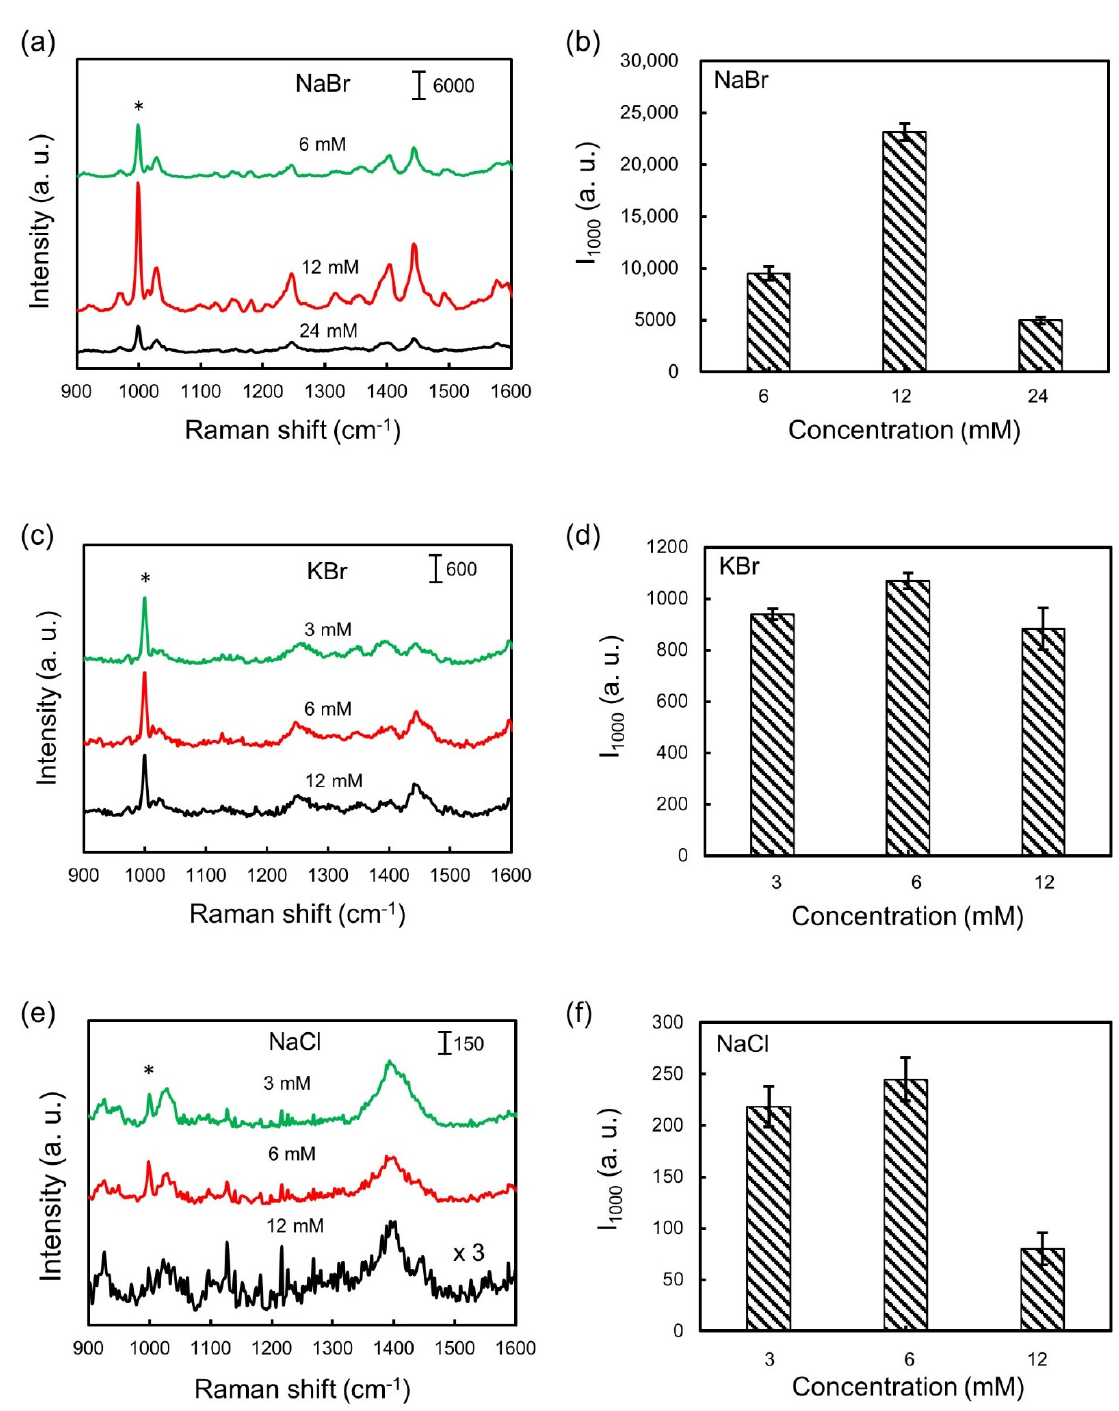
Figure 1. Effects of the kind and the concentration of alkali halide salt on SERS detection of drugs. ( a , c , e ) SERS spectra of 1 ppm MC standard solution measured using the nanoclusters induced by ( a ) NaBr, ( b ) KBr, and ( c ) NaCl of different concentrations. The characteristic Raman peak of MC at 1000 cm − 1 is marked with “*”. ( b , d , f ) The intensities of the characteristic Raman peak of MC at 1000 cm − 1 measured using the nanostructures induced by ( b ) NaBr, ( d ) KBr, and ( f ) NaCl of different concentrations. Error bars show standard deviations with n = 30.